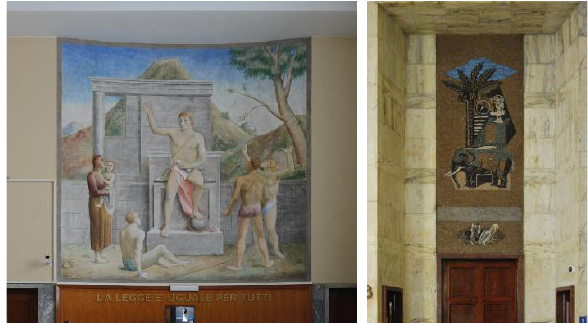
Fig 6 and 7. Two-dimensional artworks for the floor dedicated to civil trials. On the left one of the wall paintings placed inside the courtrooms, on the right one of the mosaics in the